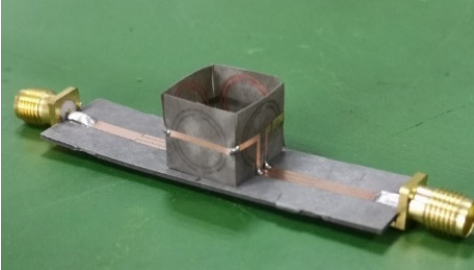
Figure 11. The fabricated sensor.